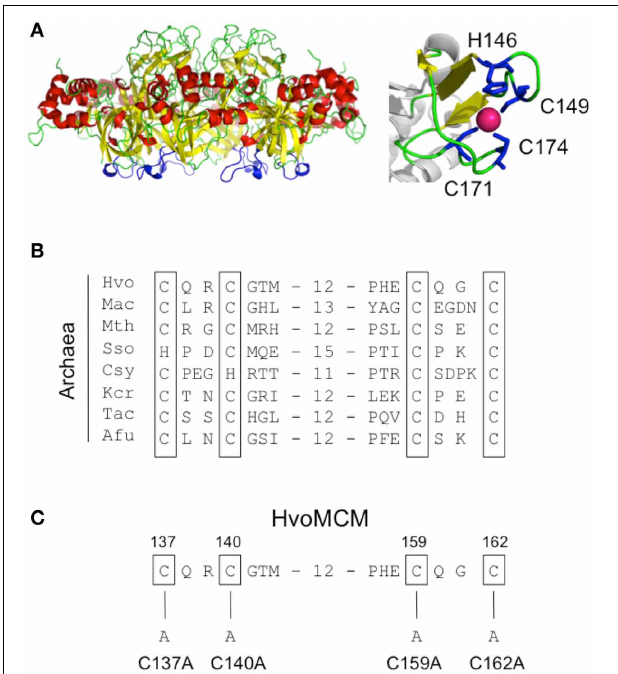
FIGURE 6 | Mutagenesis of the zinc binding domain. (A) Structure of the S. solfataricus MCM N-terminal domain hexamer (PDB 2VL6) with the zinc binding domains highlighted in blue, alongside a close-up view showing the coordination of zinc by the four conserved cysteines. (B) Multiple sequence alignment of the zinc binding domain region from diverse archaeal species (see legend to Figure 3 for key and Table 1 for strain details and protein accession numbers). Conserved cysteines are shown boxed. (C) Location and nature of intended mutations in Hfx. volcanii MCM protein. Attempts were made to construct four cysteine-to-alanine point mutants. See text for